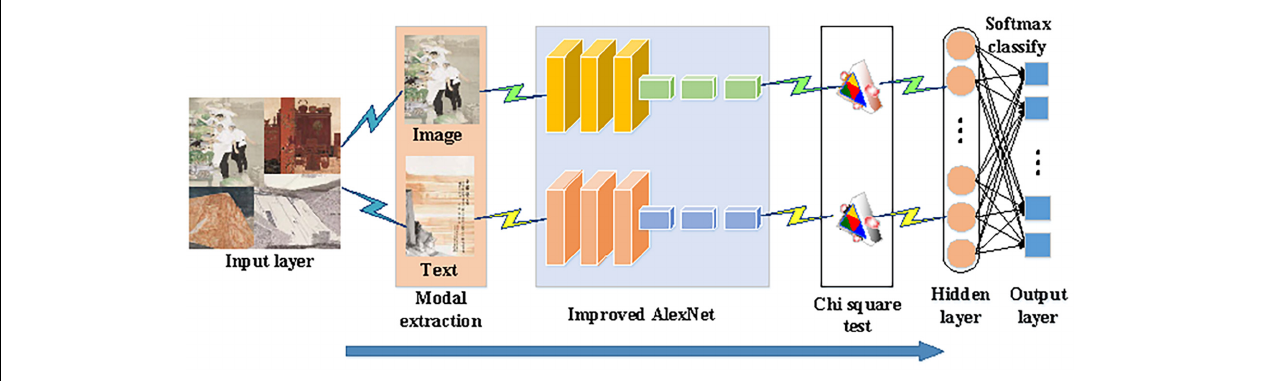
FIGURE 4 | Procedures of the proposed multimodal emotion recognition algorithm based on Chi Square Test and improved AlexNet processing Chinese paintings at the Thirteenth National Exhibition of Fines Arts in